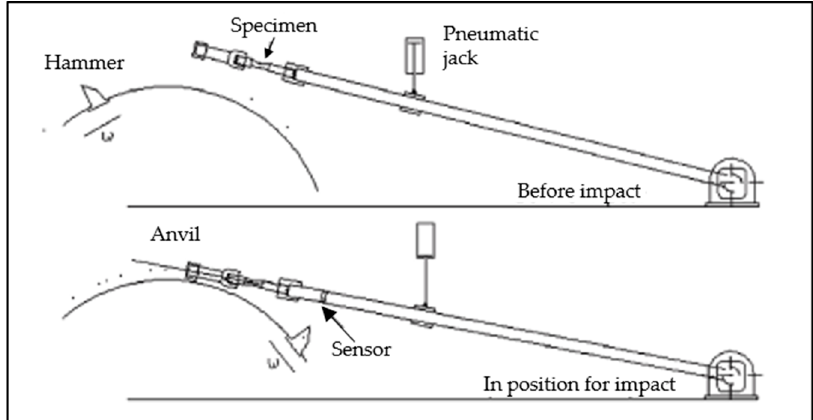
Figure 5. Schematic diagram of pendulum device before and after setting in position (the figure is reproduced from [43] with the permission from authors (open access), 2007).